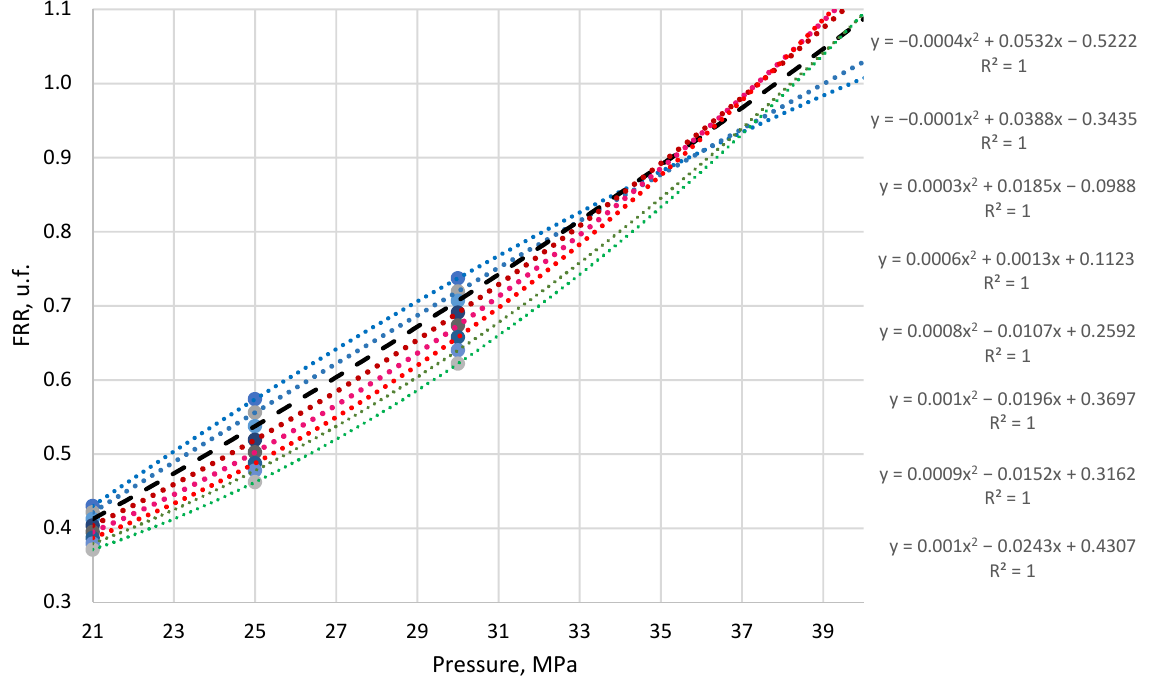
Figure 8. Extrapolation of the average FFR values from 0.05 to 0.8–1.15 PVI. The starting point for the measurements was selected at 0.05 PVI due to the first oil and gas volume measurement, and the finishing points were selected as different intervals from 0.8 to 1.15 PVI. The extrapolation of the average values was carried out using a sec- ond-order polynomial. Polynomial equation extrapolating points are located from top to bottom, respectively, for 0.8–1.15 PV. According to the results of the extrapolation, several groups of curves can be distinguished: 0.8–0.85 PVI (blue curves) have a downward trend relative to others; the curve 0.9 PVI (black dashed line) has an intermediate position be- tween the curves 0.8–0.85 PVI and a series of curves 0.95–1.05 PVI (red lines); and the curves at 1.1–1.15 PVI (green lines) have a similar trend with the curves at 0.95–1.05, but they are separated and shifted towards high pressures. Returning to the dynamics of displacement, the curve for the interval up to 0.9 PVI (black dashed line) occupies an intermediate position. In addition, this is the last point that characterizes the displacement mode before the gas breakthrough point for miscible injection at pressures of 40–45 MPa. Based on this, the intersection of the extrapolation curve with an abscissa equal to one for this interval can be considered the theoretical point of achieving miscibility. The value calculated based on the curve equation was 37.09 MPa. A summary of the results of the determination of MMP using all of the above calcu- lations is shown in Figure 9.